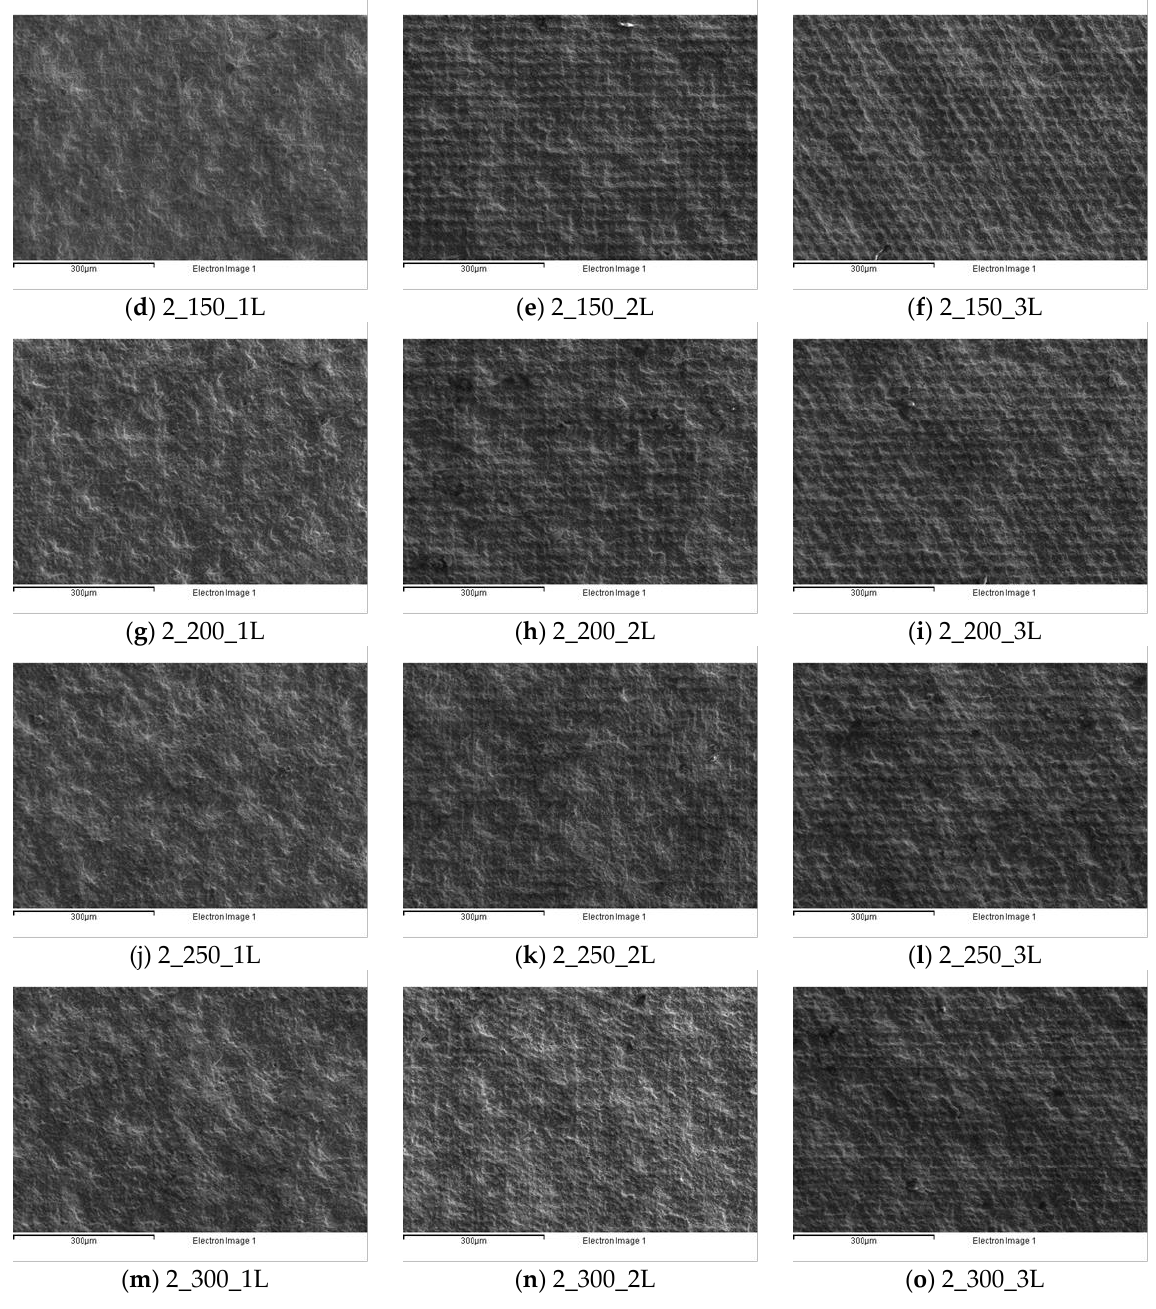
Figure 7. Morphological analysis for the second experimental series. ( a ) 2_100_1L; ( b ) 2_100_2L; ( c ) 2_100_3L; ( d ) 2_150_1L;